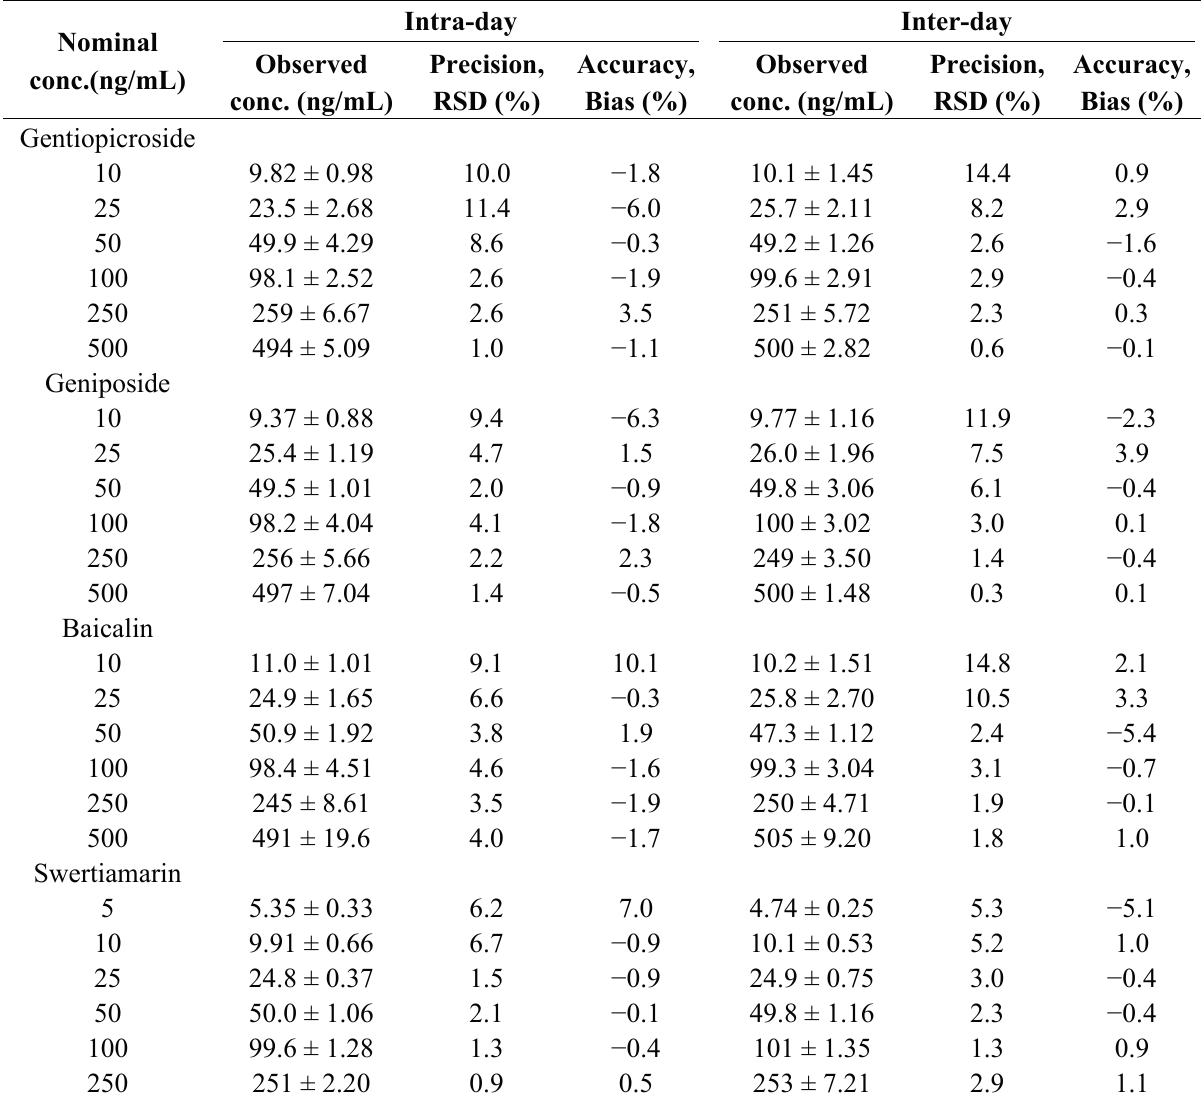
Table 2. Intra-day and inter-day precision and accuracy for the determination of four